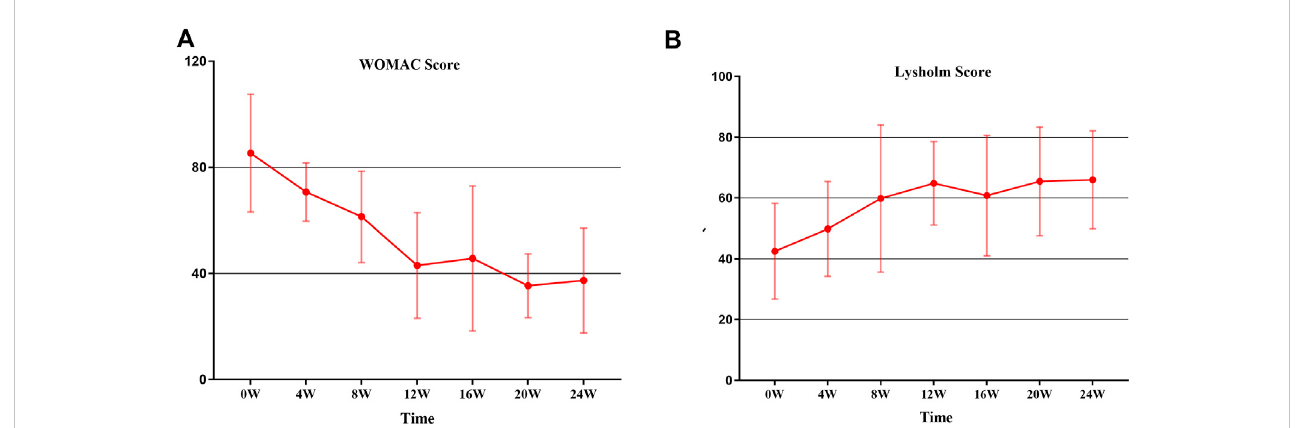
FIGURE 6 ThetrendinWOMACscore andLysholmscore from0to24 W. (A) WOMAC Score:thedecreasing trendofWOMAC isobviousbetween0and 12 weeks, and leveled off gradually at 12 – 24 weeks. (B) Lysholm score: The constant increase was observed from 0 to 12 weeks; thereafter, a relative stability was